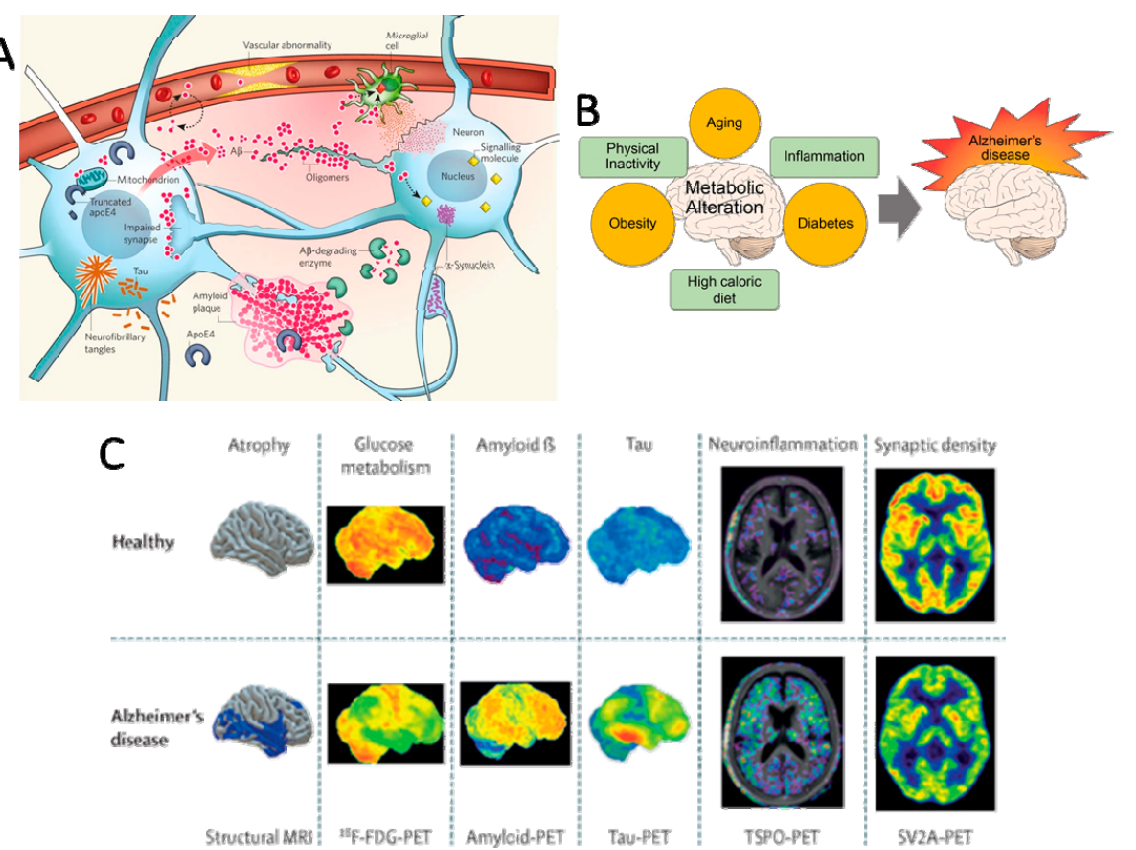
Figure 1. Alzheimer’s Disease spectrum. ( A ) Key players in the pathogenesis of Alzheimer’s disease (AD). Reprinted with permission from [12]. Copyright 2009, Nature Publishing Group. ( B ) Aging and metabolic diseases alteration of brain metabolism, which progressively causes AD. Reprinted from [65], Copyright 2017, Yonsei University College of Medicine. ( C ) Differential diagnosis of AD using neuroimaging biomarkers. Reprinted with permission [66]. Copyright 2009, Elsevier.